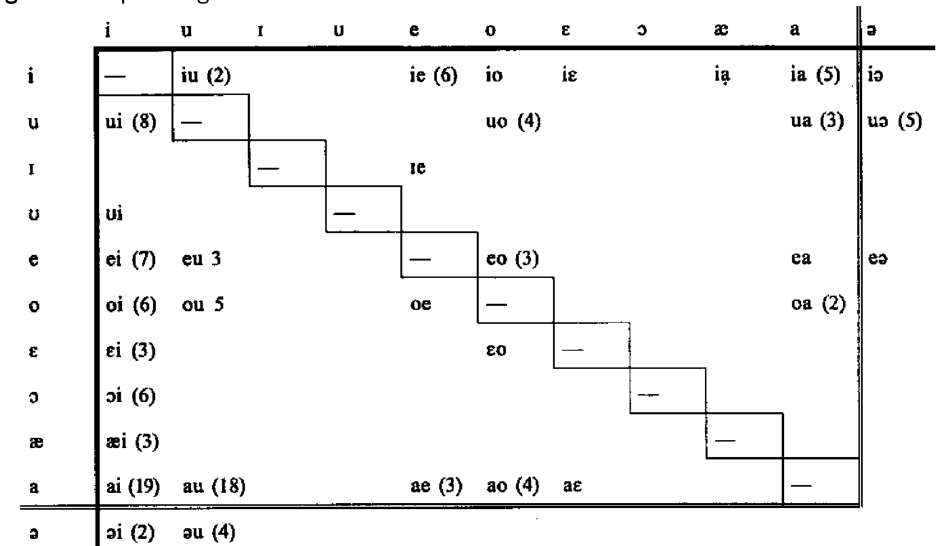
Figure 3 . Diphthongs in UPSID 1992